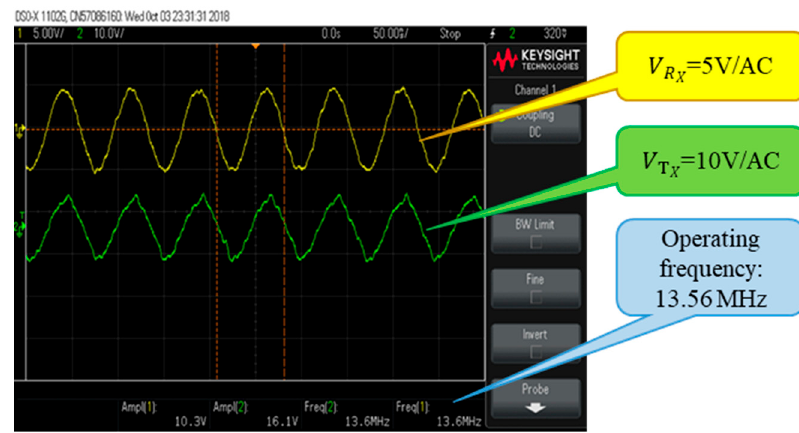
Figure 19. Voltage waveform in the transmitter coil ( V T